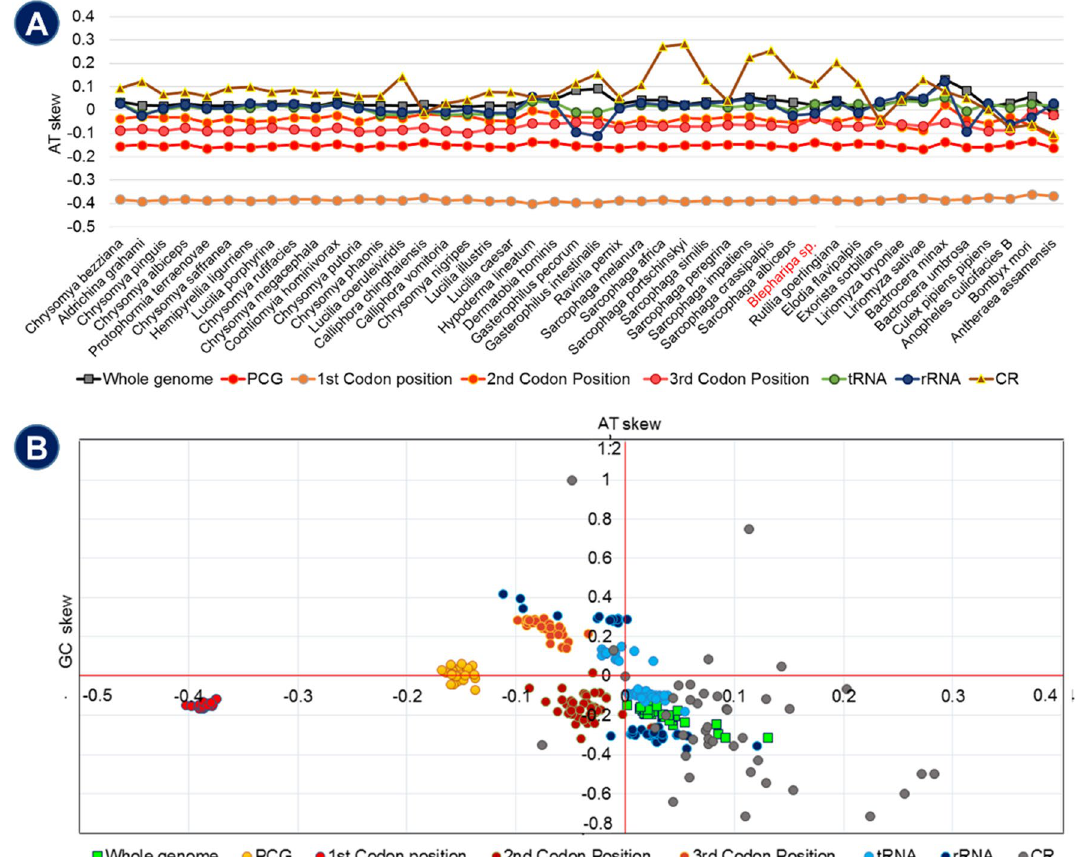
Figure 4. Nucleotide skew plot; ( A ) Trend of AT skew across the Oestroidea superfamily and outgroups. ( B ) AT skew vs GC skew of different genetic position of 44 organisms (CR shows maximum variation and 1st codon position shows least